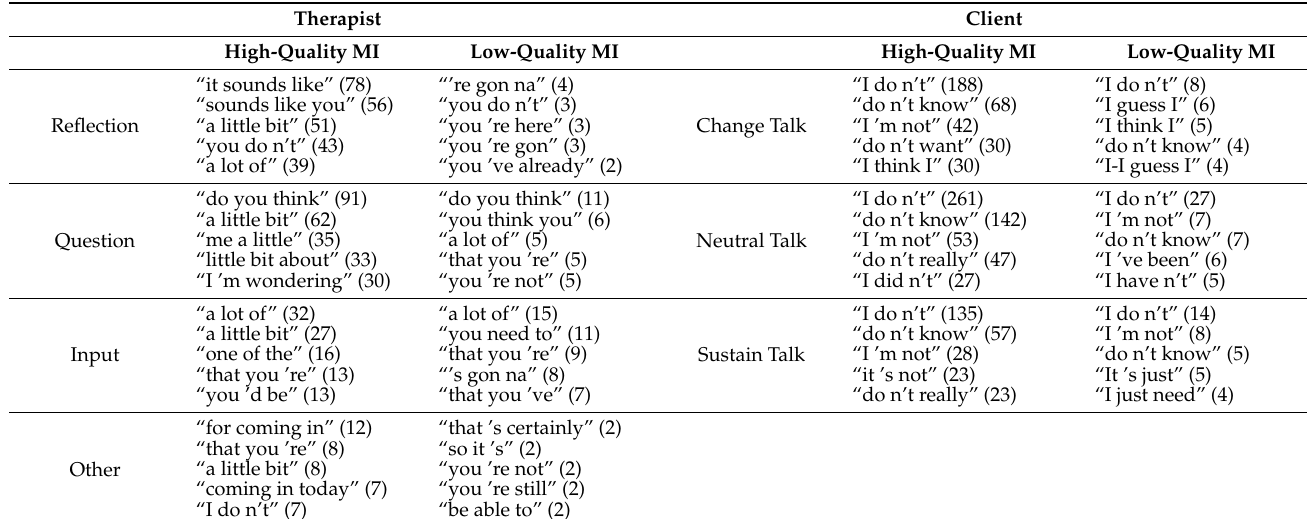
Table 13. Most frequent 3-grams of (1) therapist utterances of different (main) behaviours and (2) client utterances of different talk types, in high- and low-quality